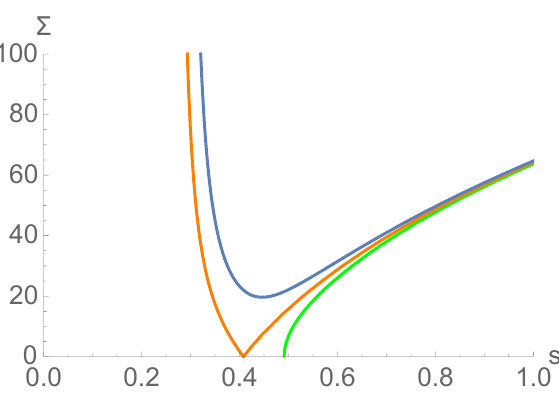
Figure 4 . (cid:6) as a function of the black hole radius s for (cid:12)xed charge = 1 : 2 ; 1 and : 8 depicted in blue, orange and green, respectively. Here we have chosen ‘=